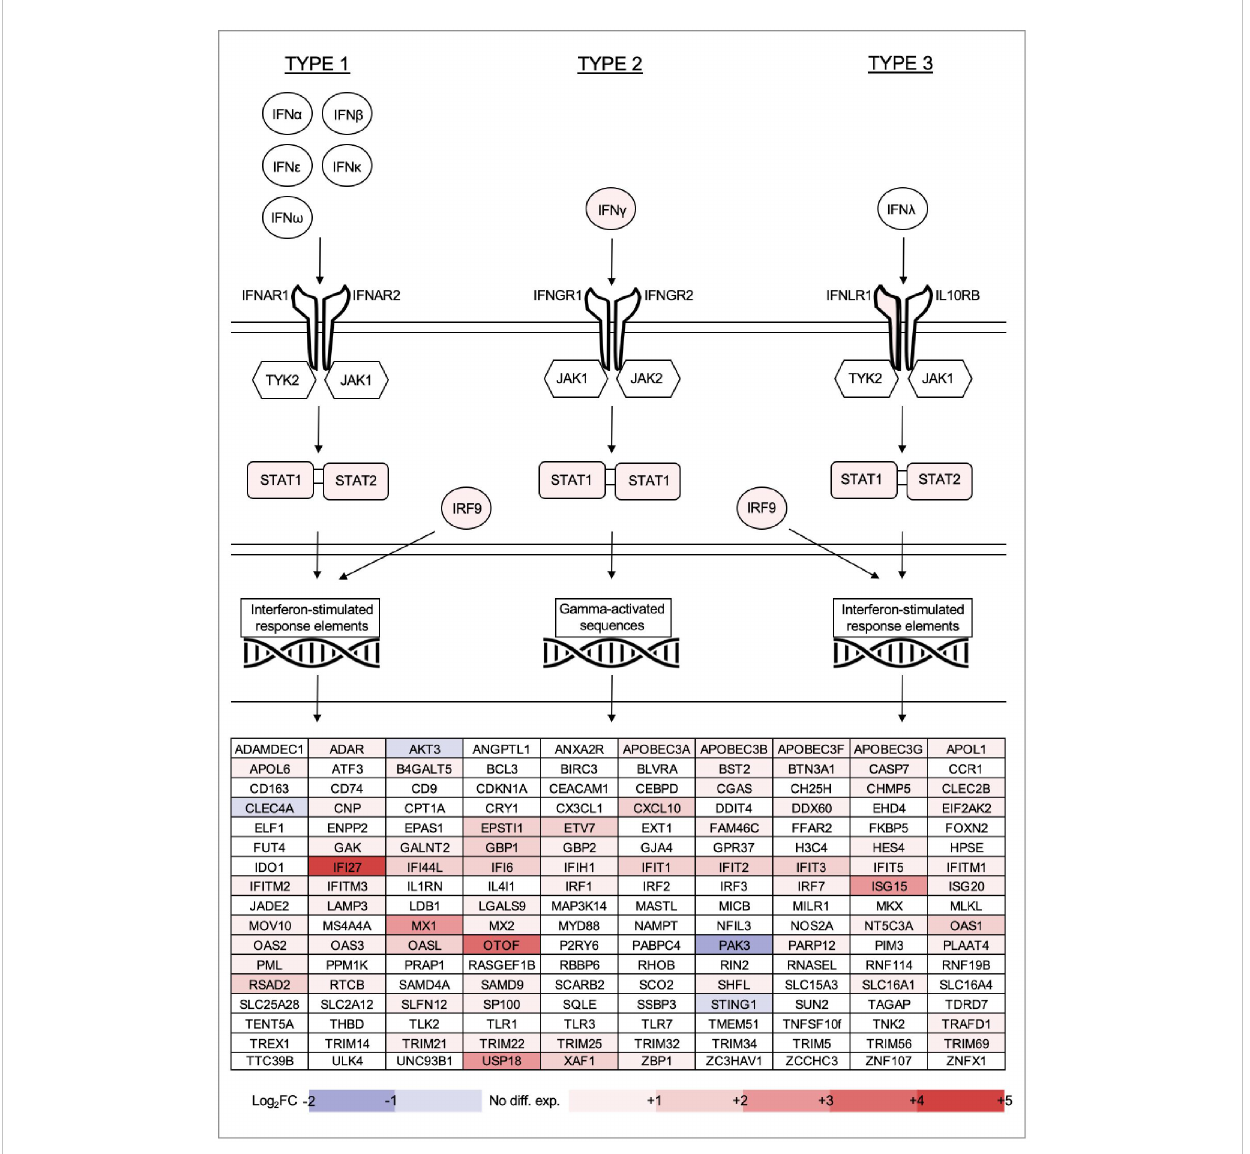
FIGURE 8 Gene expression changes for all types of interferon, key components of the Type 1, 2 and 3 interferon signalling pathways, as well as 170 other interferon-stimulated genes (ISGs) with established antiviral functions. ISGs listed in alphabetical